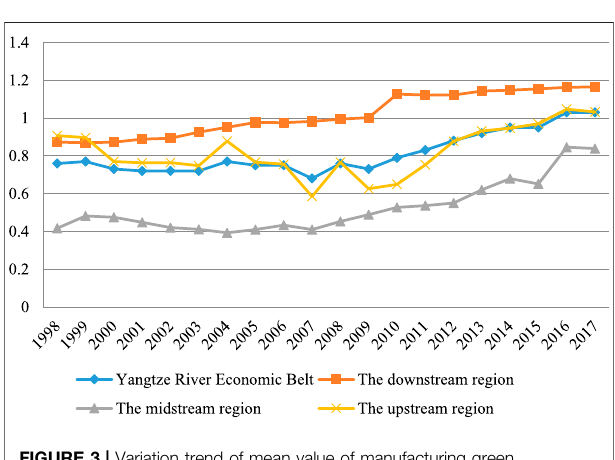
FIGURE 3 | Variation trend of mean value of manufacturing green development ef fi ciency from (1998 – 2017).